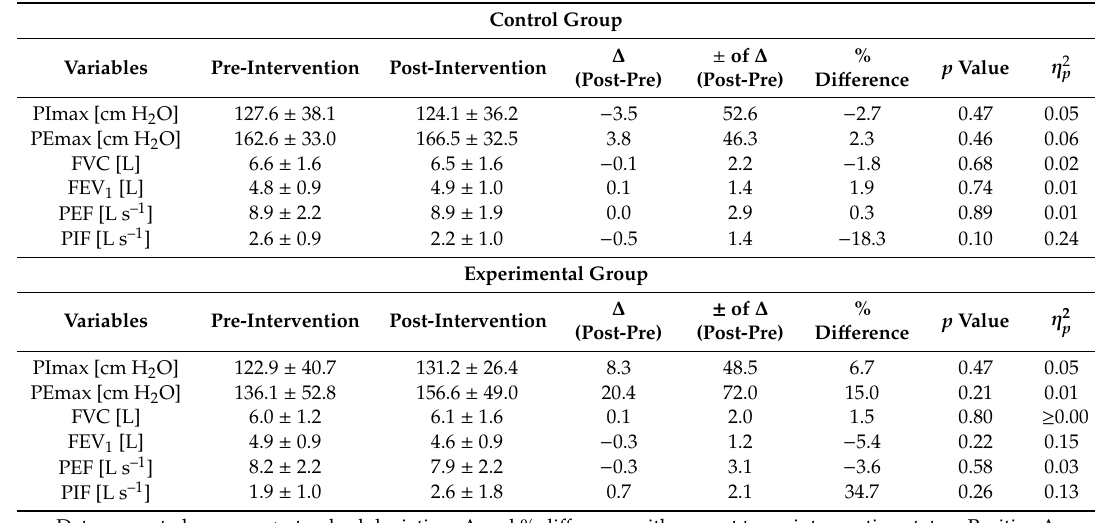
Table 2. Pre- and postintervention within-group comparisons (PImax, PEmax, FVC, FEV 1 , PEF, PIF). Control Group